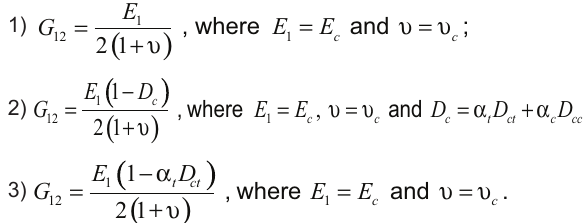
Figure 8 – Effect of damage of transversal elastic modulus on load-displacement behavior